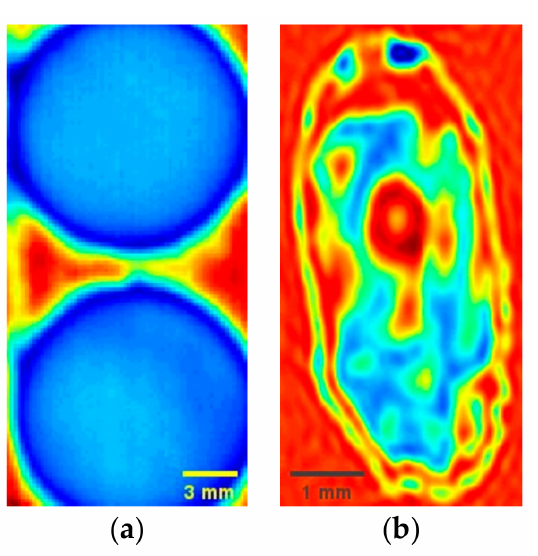
Figure 4. The full scan terahertz images of the two samples. ( a ) Circular solids made from wheat flour; ( b ) wheat